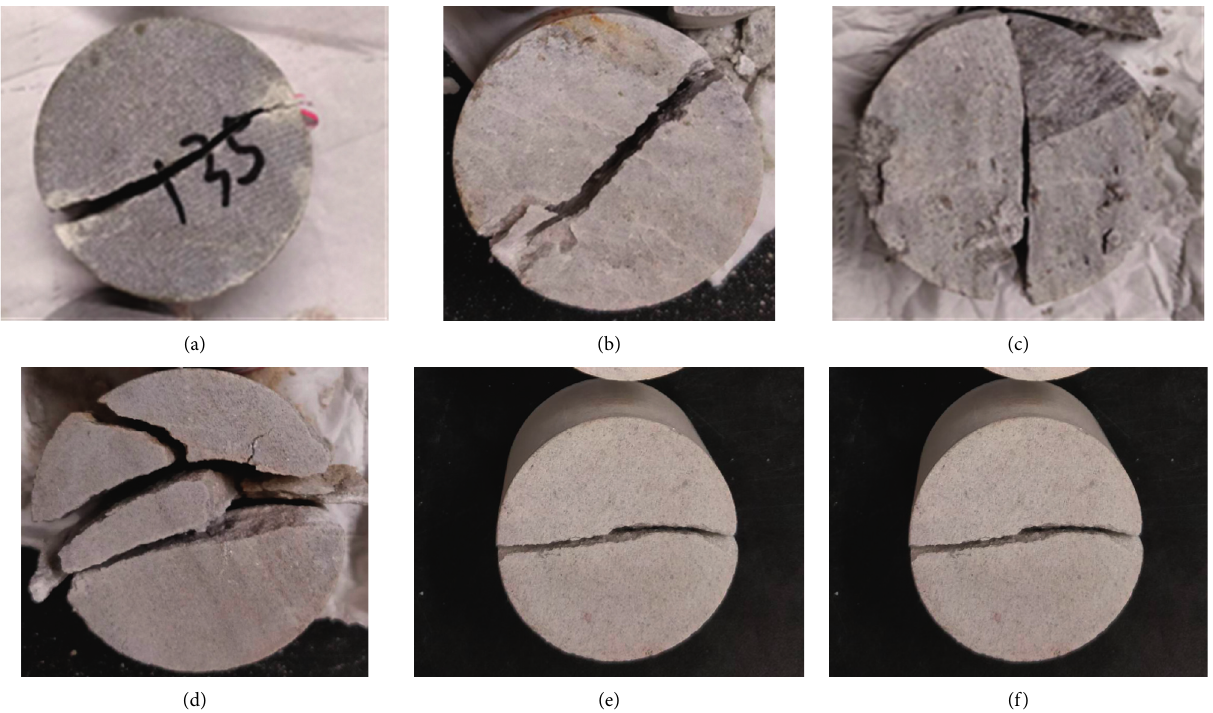
Figure 10: Rock fracture patterns for BTS test under various temperatures. (a) 25 ° C. (b) 100 ° C. (c) 200 ° C. (d) 400 ° C. (e) 600 ° C. (f) 800 ° C. Table 2: Tensile strengths of the rock under different temperatures. Temperature ( ° C) 25 100 200 400 600 800 Tensile strength σ (MPa) 6.82 6.64 6.44